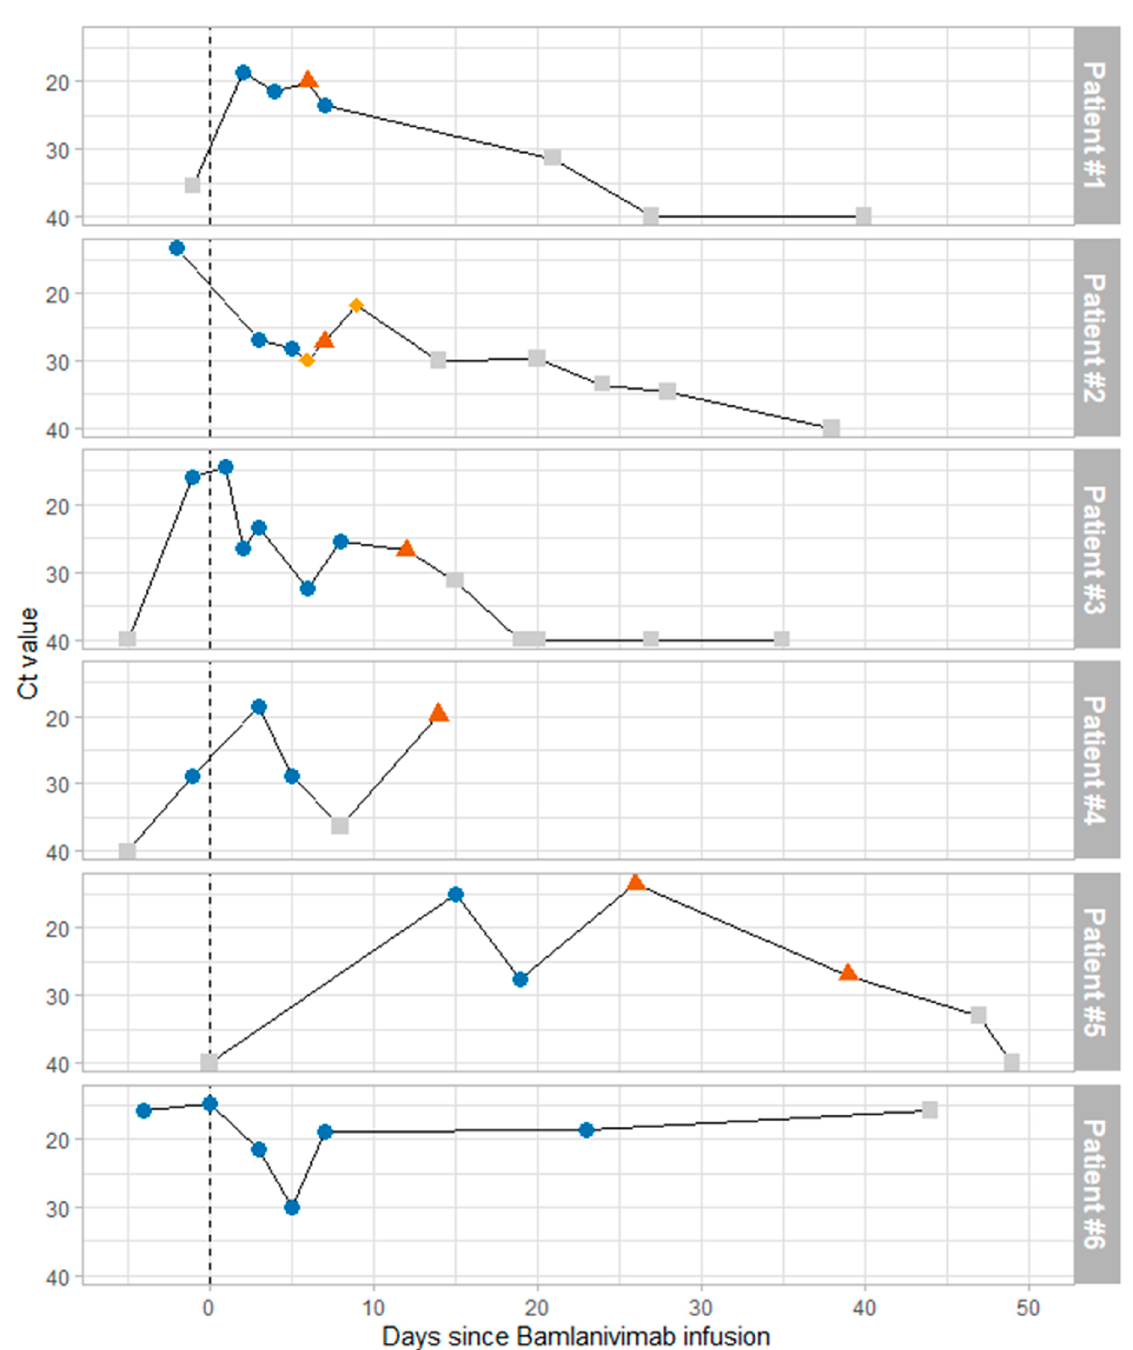
Figure 1. Virological evolution of patients after bamlanivimab infusion. Viral load, estimated by Ct values, is depicted on the vertical axis. Time since bamlanivimab infusion is depicted in days on the horizontal axis. Blue circles indicate that no mutation was detected at position 484 of the spike protein, red triangles indicate E484K mutation, and yellow diamonds indicate E484A mutation. Gray squares indicate the inability to check for E484 mutations due to low viral load (usually Ct values above 30).